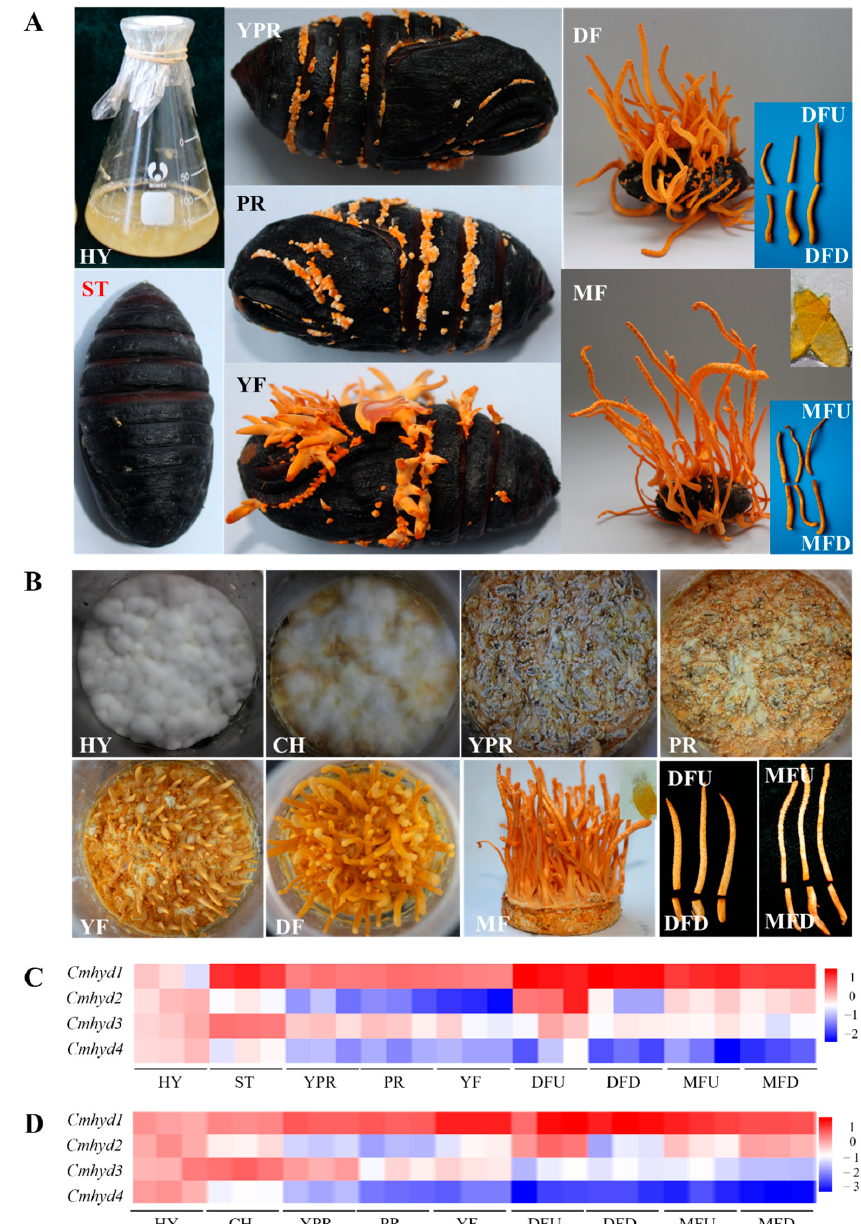
Figure 3. Transcript levels of hydrophobin genes during the fruiting body development. ( A ) Developmental stages of C. militaris cultured on Antheraea pernyi . HY: the hyphae used for inoculation on A. pernyi ; ST: sclerotium (mummified pupae) before stroma development; YPR: the mycelium knot tissue before stroma development; PR: sclerotium with initial stroma (stroma < 1 cm); YF: sclerotium with early stage stroma (1 cm < stroma < 2 cm); DF: sclerotium with developed stroma (stroma > 5 cm); MF: fruiting body with mature perithecia, ascus and ascospores. ( B ) Developmental stages of C. militaris cultured on wheat media. HY: the hyphae cultured under darkness; CH: the colored hyphae after light irradiation for 4 days; YPR, PR, DF and MF were similar with that cultivated on the insect; MFU: the top fertile part with a superficial visible perithecia; MFD: the sterility stipe. DFU and DFD were the corresponding parts of MF. ( C ) Heatmap of the transcription levels of hydrophobin genes of C. militaris cultivated on A. pernyi . ( D ) Heatmap of the transcription levels of hydrophobin genes of C. militaris cultivated on wheat media. The relative expression levels at the different stages were based on the standard levels of the HY stage in the A. pernyi and wheat media, respectively. The different colors of ( C ) and ( D ) represent the log10 of gene transcript folds compared with